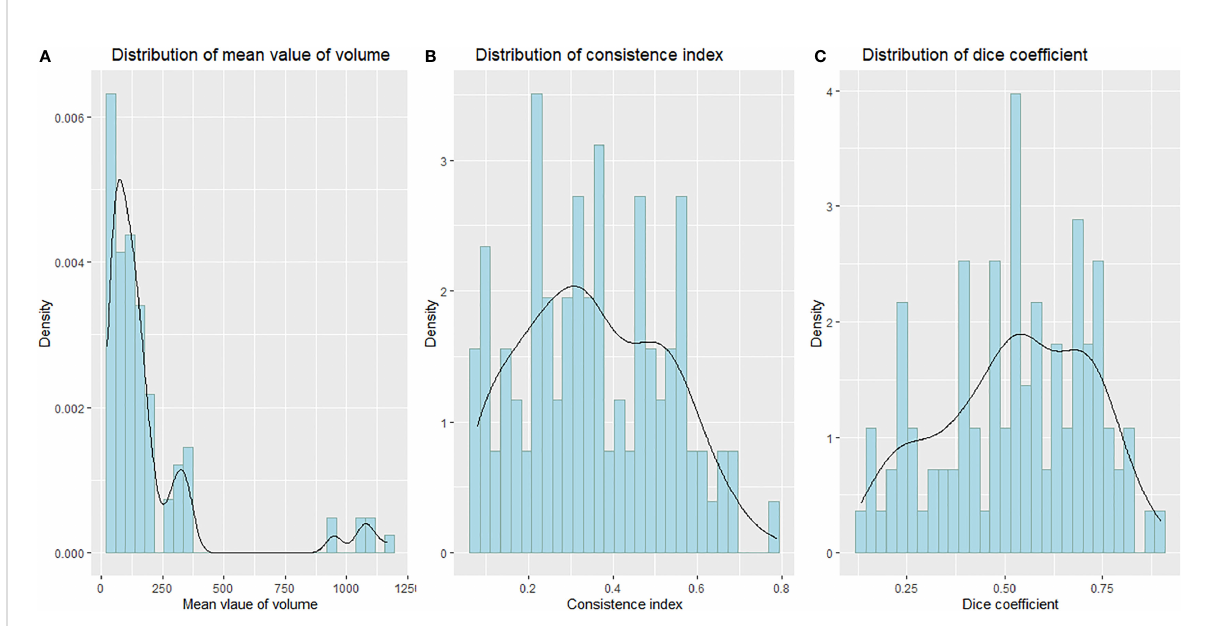
FIGURE 2 Probability density distribution curve histogram of the mean volume, CI, and